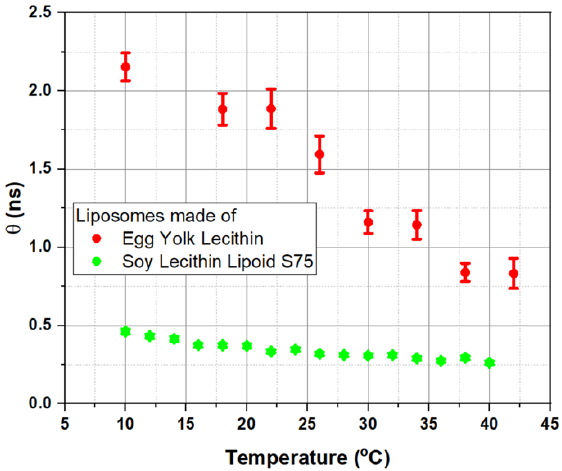
Figure 9. Changes in microviscosity of membranes of liposomes with different phospholipid compositions revealed by time-resolved fluorescence anisotropy of TM-BODIPY probe at 1 μM concentration. θ is rotational correlation time. Measurements were performed on two types of liposomes: green marks—S75 liposomes, produced from soy lecithin lipoid S75 containing 75.3% phosphatidylcholine and 8% phosphatidylethanolamine; red marks—liposomes prepared from fresh egg yolk lecithin (for the data on the composition please refer to [64]).